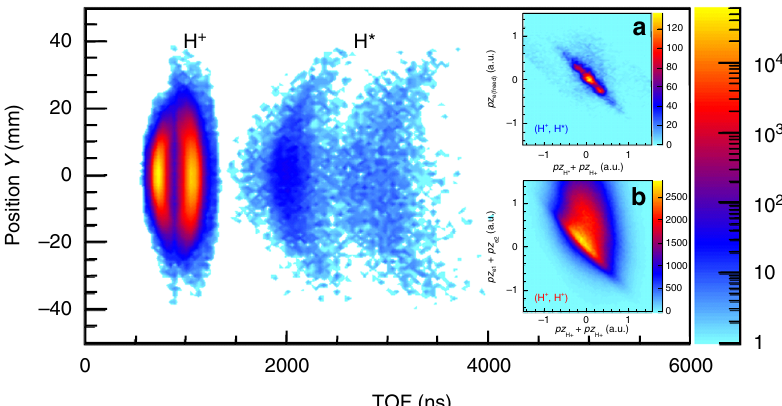
Fig. 5 Coincident detection of the nuclear fragments of the breaking H 2 . The density plot of the yield of the measured nuclear fragments (H + and H * ) of the (H + , H + ) and (H + , H * ) channel, as a function of the TOF and y position. The insets a and b display the momentum correlation maps of the measured fragments of the (H + , H * ) and (H + , H + )